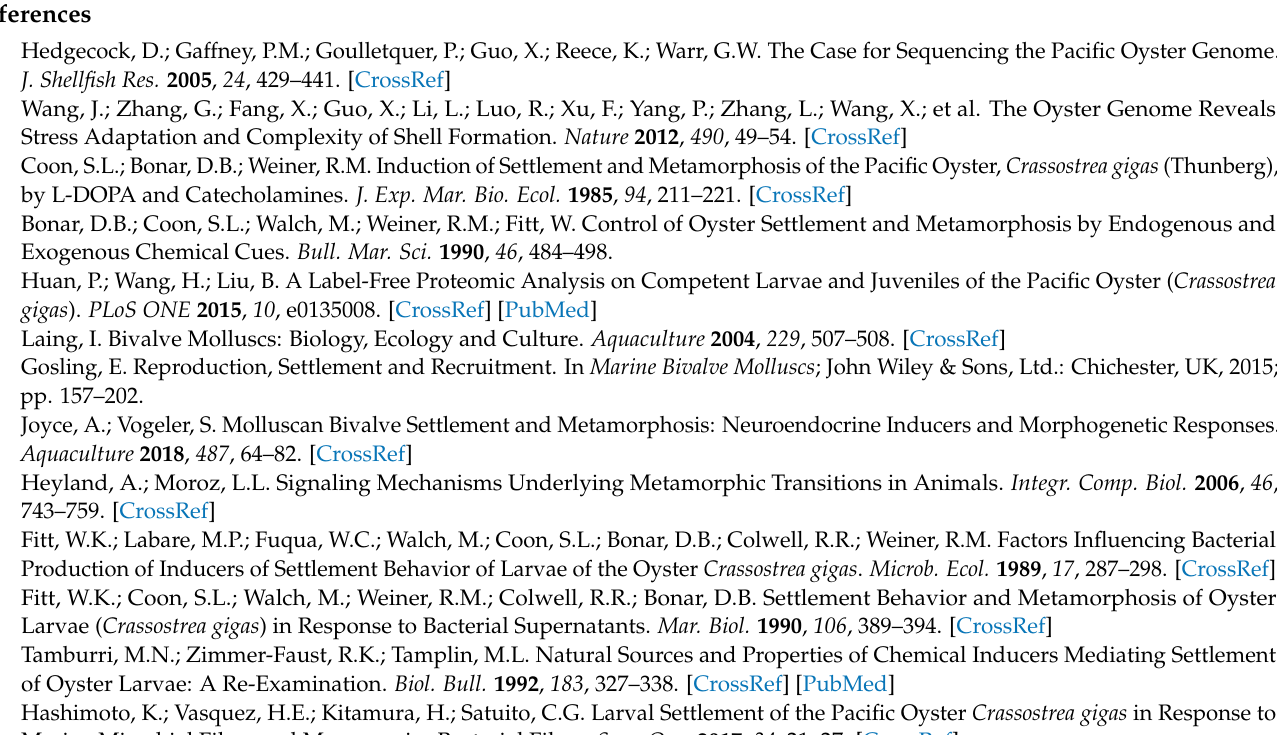
C. gigas transcriptome. Table S3: Results of the Blastx homology search for the differential transcript expression involved in the Gene Ontology enriched processes of the C. gigas